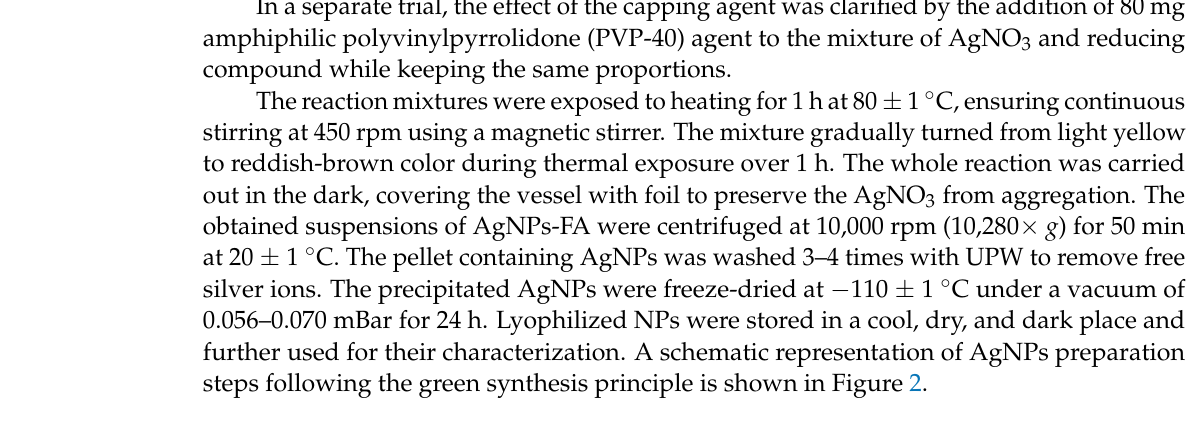
Figure 2. A schematic representation of major steps undertaken for the preparation of silver nano- particles following the green synthesis principle using rye bran-derived trans -ferulic acid recovered by enzymatic hydrolysis with cellulose-degrading enzyme Viscozyme L.